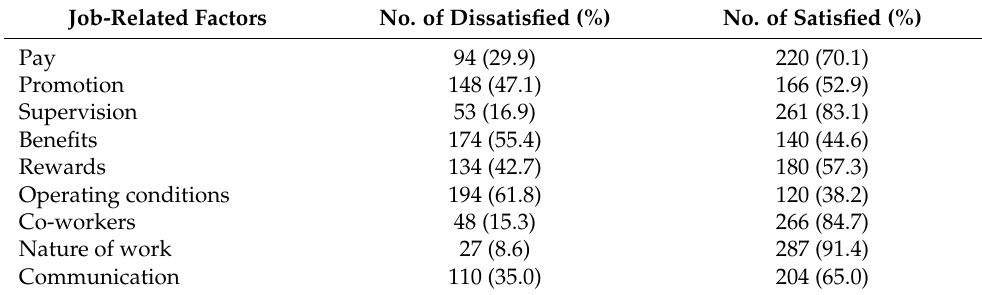
Table 4. Proportion of various levels of satisfaction towards job-related factors among healthcare workers in ‘Type 2 Health Clinics’ ( n =